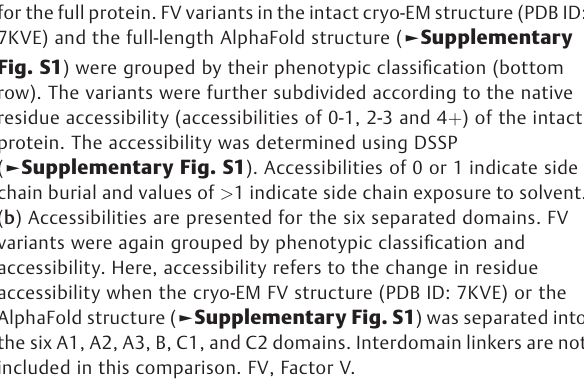
TH Open Vol. 7 No. 1/2023 © 2023. The